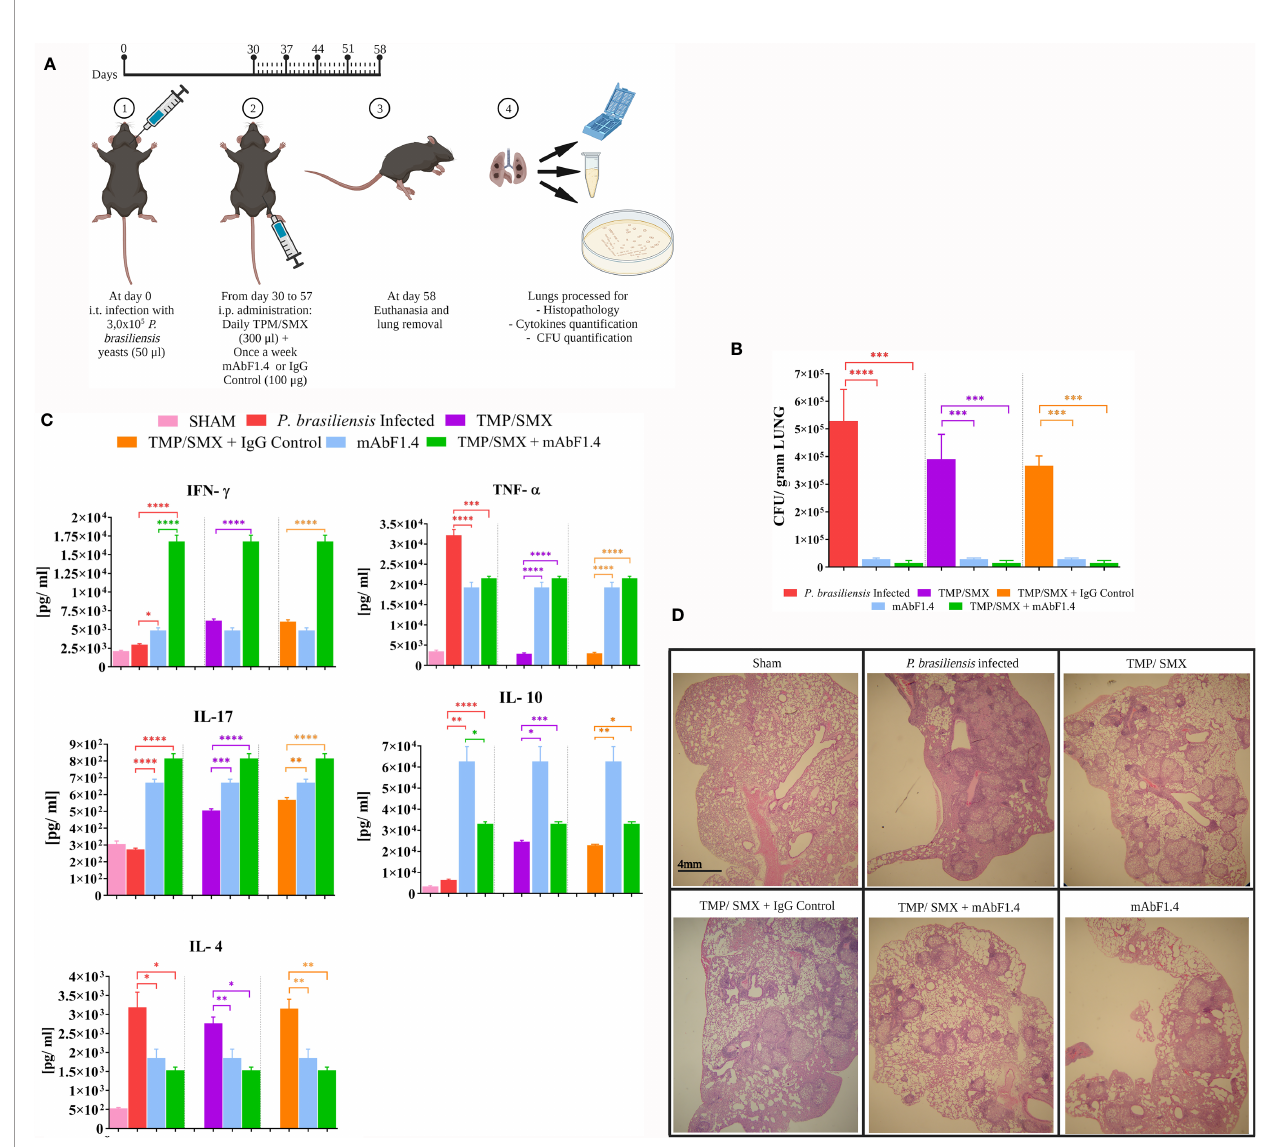
FIGURE 3 | In vivo experiments to determine the ef fi cacy of combined immunotherapy with mAbF1.4 and TMP/SMX. Bars depict means and SEMs of three independent experiments. Overall differences in the variance of all treatments were assessed for signi fi cance by repeated-measures one-way ANOVA, with results of Tukey ’ s post hoc test for multiple comparisons displayed in the graph, ****P < 0.0001. (A) Immunotherapy protocol with the TMP/SMX and mAbF1.4 represented. Groups (n = 5) were randomly organized accordingly: (i) infection control: mice infected with 3,0 ×10 5 Pb18 yeast cells; (ii) Pb 18 infected and treated with TMP/ SMX; (iii) Pb 18 infected and treated with TMP/SMX + mAb F1.4 (400 µg); (iv) infected and treated with TMP/SMX + IgG Control (mAb4G2; 400 µg); (v) Sham (uninfected, untreated). After 30 days of infection, animals were treated intraperitoneal via, daily with TMP/SMX (NeoQu ı ́ mica) at 15 mg/kg/SMX: 3 mg/kg dose and once a week (100 µg) mAbF1.4, for 4 weeks. By day 58 the animals were euthanized, lungs were sterilely extracted and processed. Created with Biorender.com. (B) Evaluation by pulmonary fungal burden. Graphic shows the CFU/gram of tissue, determined by the viable yeasts number present in lungs macerate for every group. (C) Evaluation by pulmonary cytokine pro fi le of the experimental groups. Supernatants from lung macerated were assayed for cytokines IL-4, IL-10, IL-17, TNF- a and IFN- g by ELISA. The graphic shows a comparison of the treatments (TMP/SMX + mAbF1.4 and mAbF1.4) vs. the control groups (infected non treated, TMP/SMX and TMP/SMX + IgG control). (D) Evaluation by lung histopathology of sections from mice groups at 4X. Sections slides were stained with hematoxylin and eosin staining to evaluate morphology, in fl ammation and the granuloma formation. *p 0.01; **p:0.001 ;